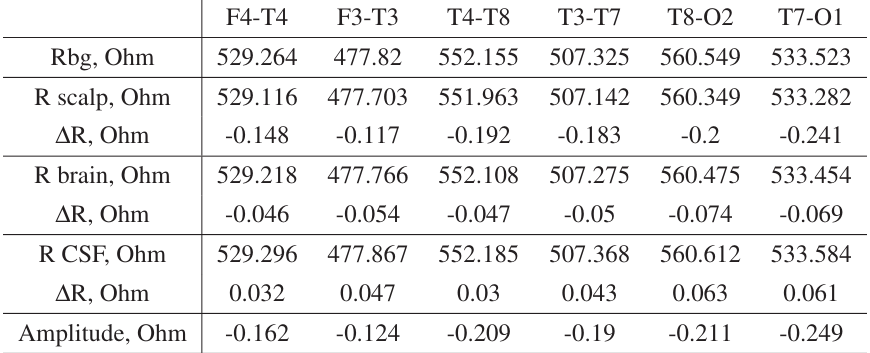
Tab.1: Calculated amplitudes of